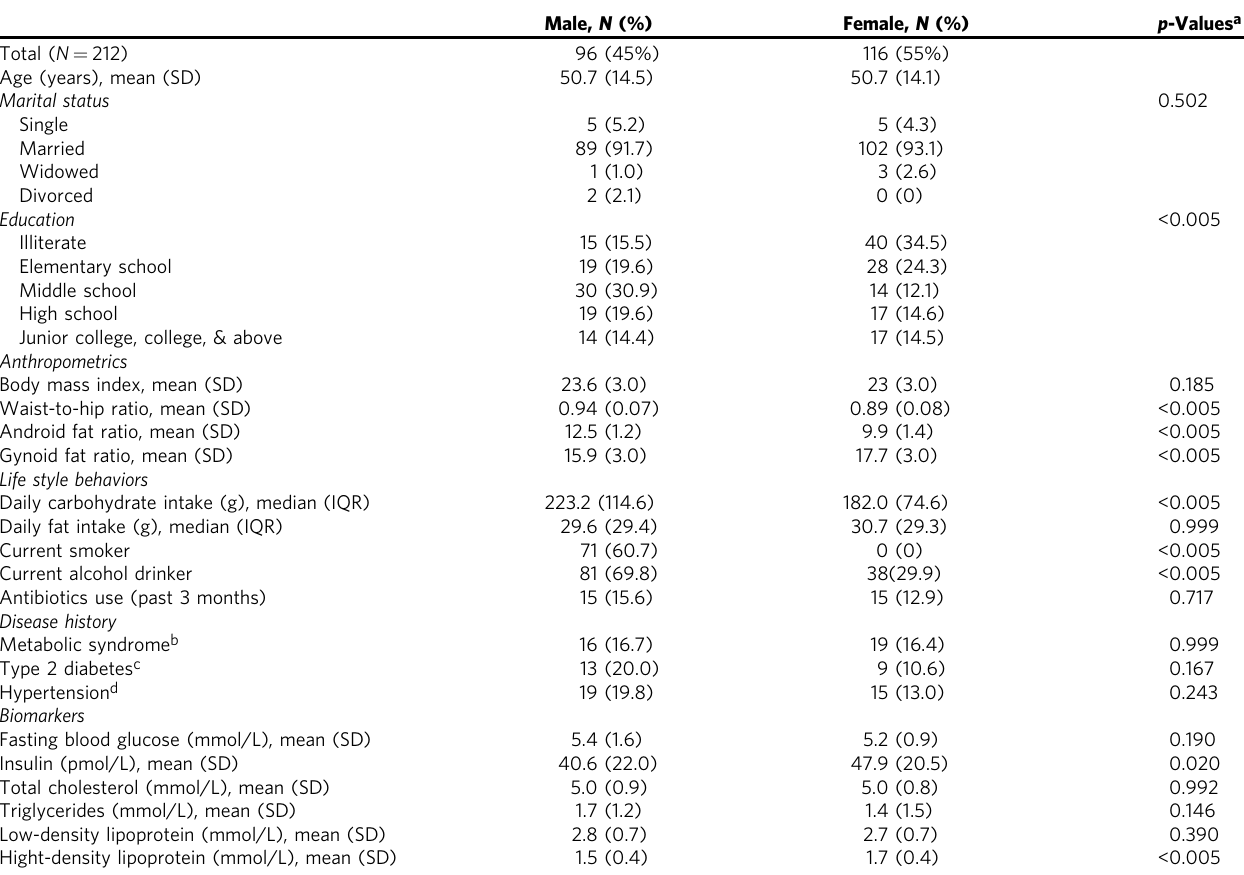
Table 1 Demographic